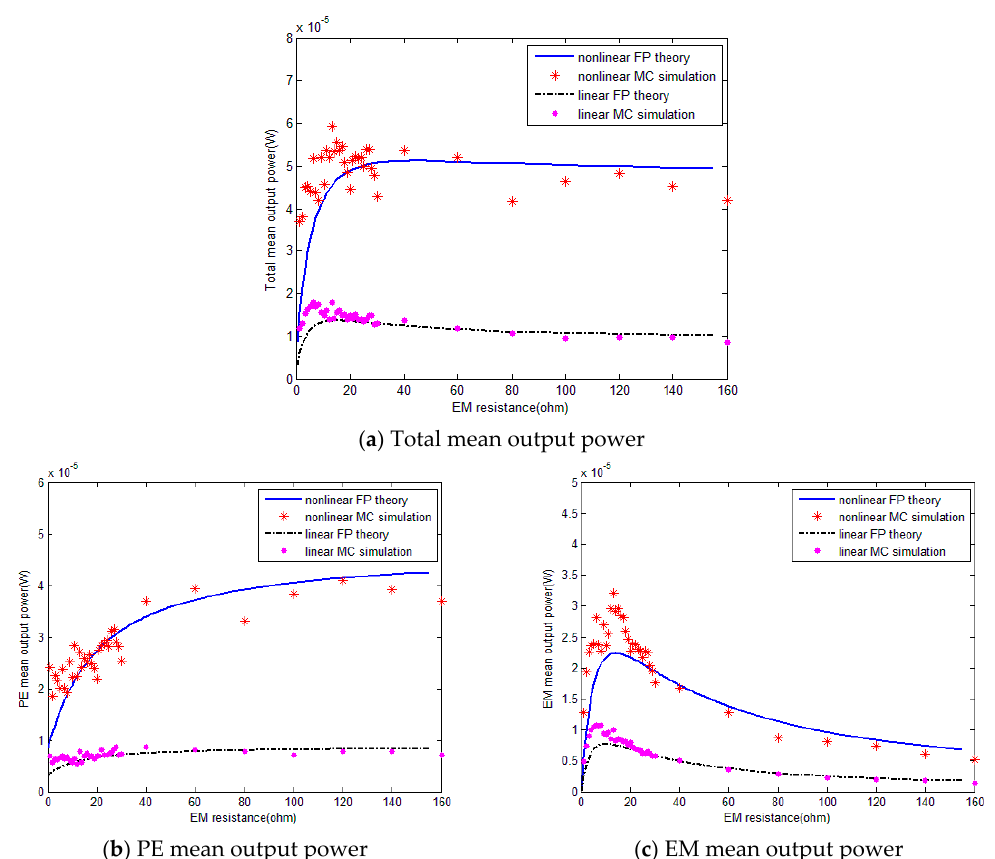
Figure 3. Theoretical and numerical mean output power of hybrid energy harvester with PE load resistances.